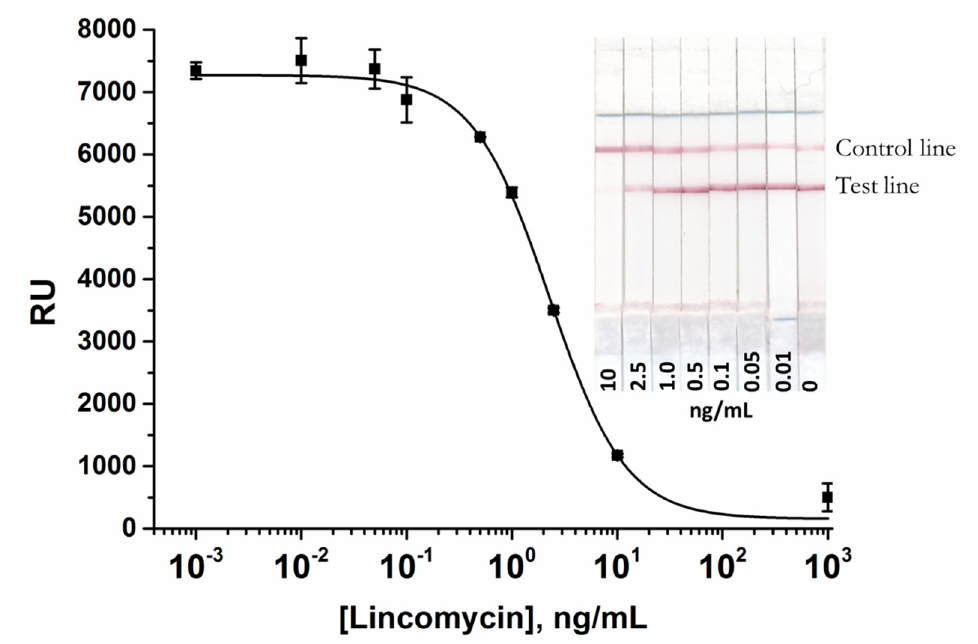
Figure 3. Calibration curve of LIN in the AuNP-based LFIA and the digital photographs of the LFA strips after conventional AuNP-based LFIA procedure. The LIN-BSA conjugate was applied at the test line at a concentration of 0.5 mg/mL. The AuNPs-anti-LIN antibodies solution was applied at a concentration corresponding OD 520 = 1. LIN concentrations are given at the bottom of the test strips. The error bars indicate the standard deviations for three measurements.